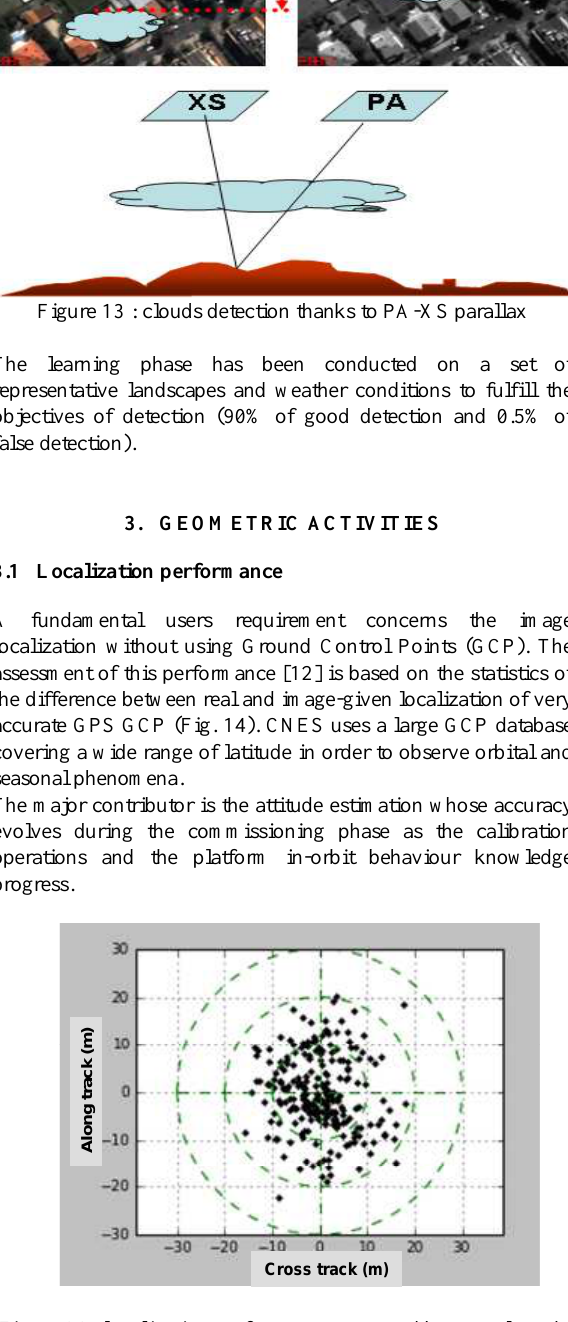
Figure 14 : localization performance measured between launch Figure 12 : example of PAN-sharpen images for initial and new and April 5, techniques